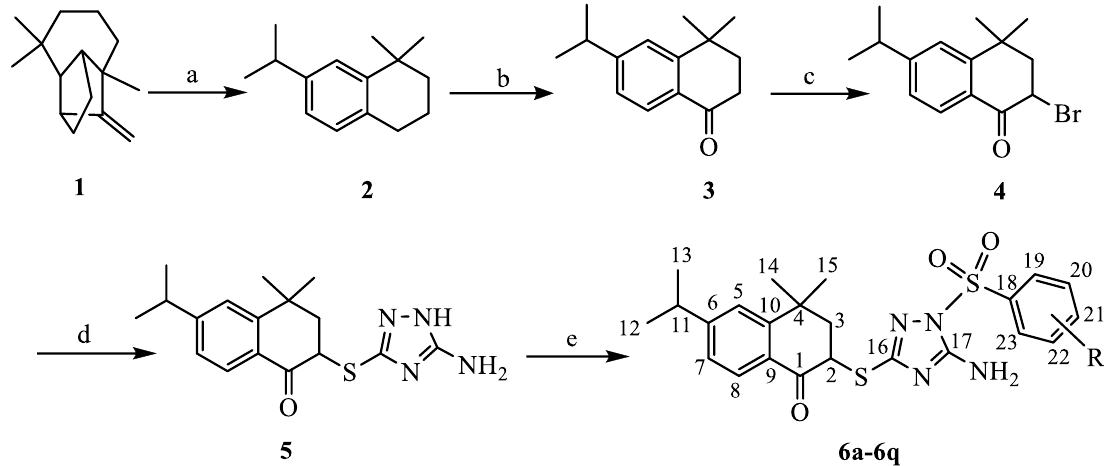
Scheme 1: The synthetic route of 6a – 6q (Table 1). Reagents and conditions: ( a ) Nano-crystalline